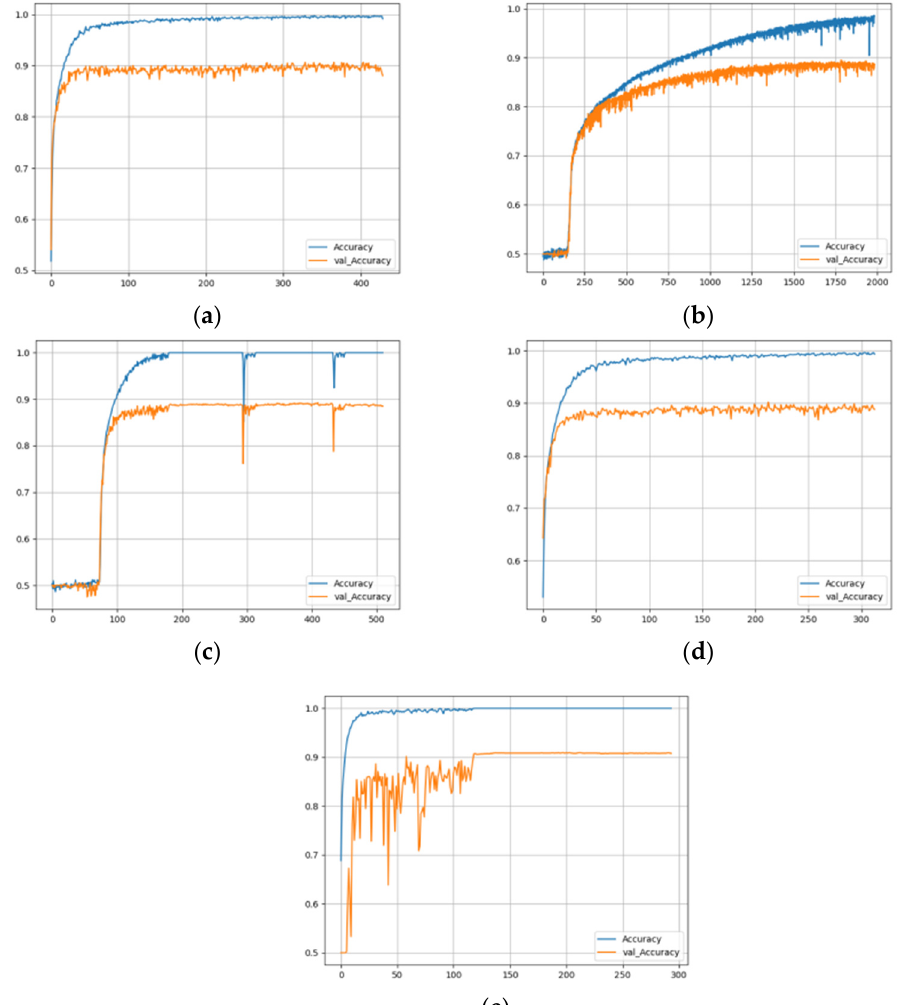
Figure 15. Training history: ( a ) CNN; ( b ) GRU; ( c ) CRNN; ( d ) TwoStream; and ( e ) ResNet-50.